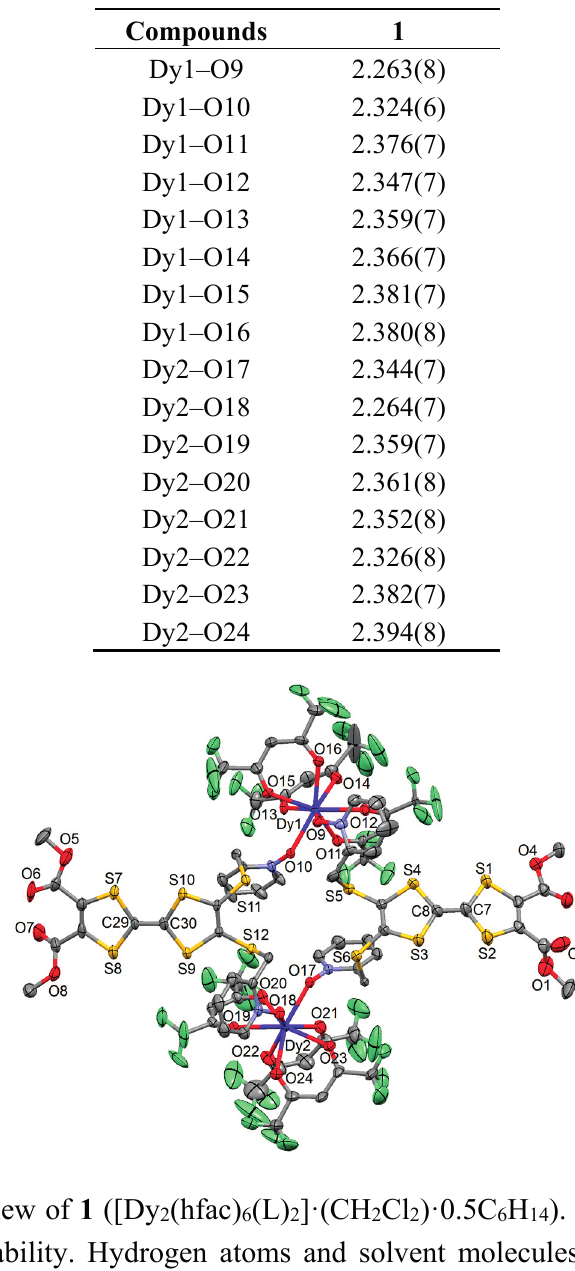
Table 2. Selected bond lengths (Å) for compound 1 .